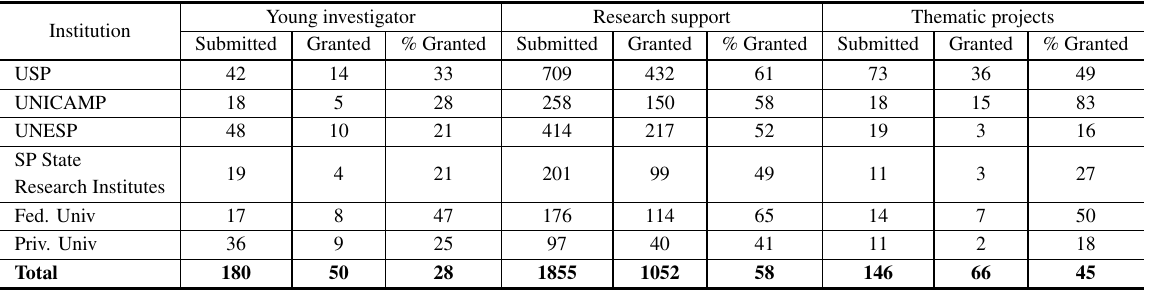
Submissions and percentage of approvals per institution in